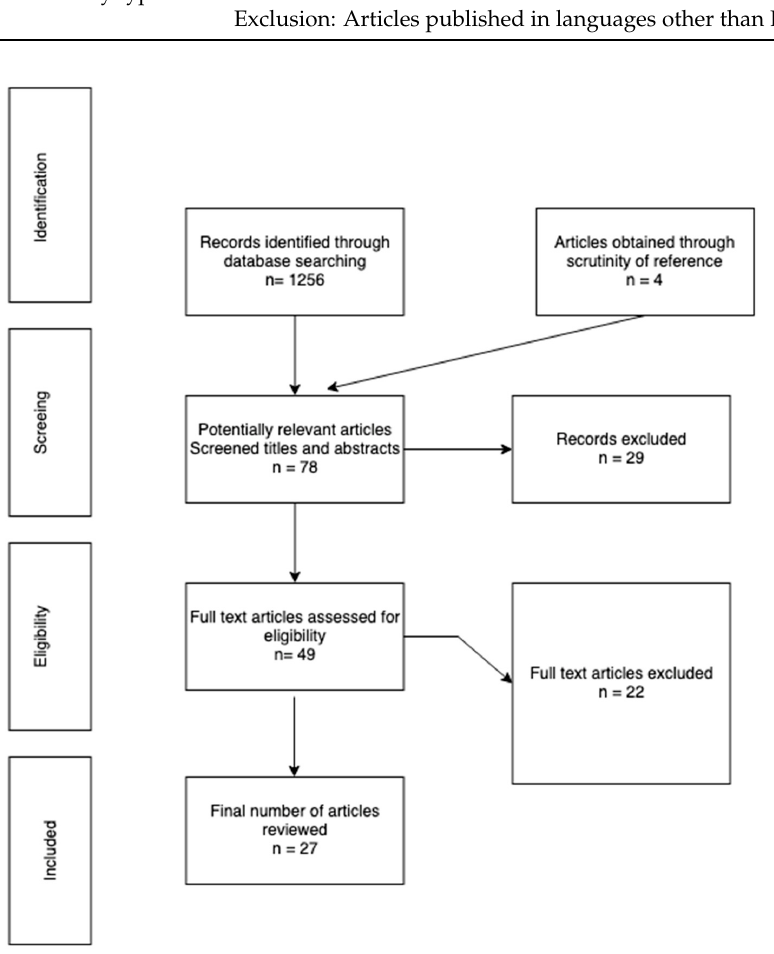
Figure 1. Study selection and exclusion